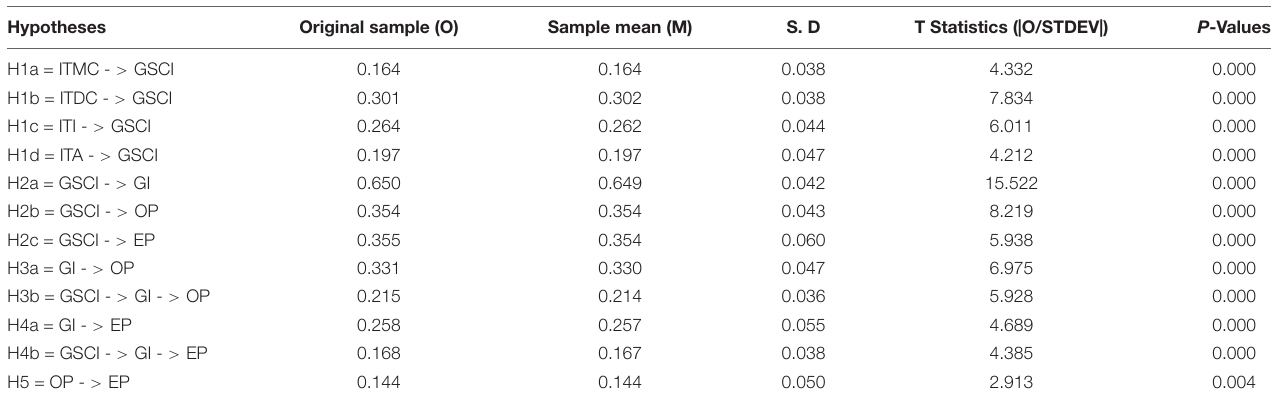
FIGURE 2 | SEM results for hypotheses testing. TABLE 6 | SEM